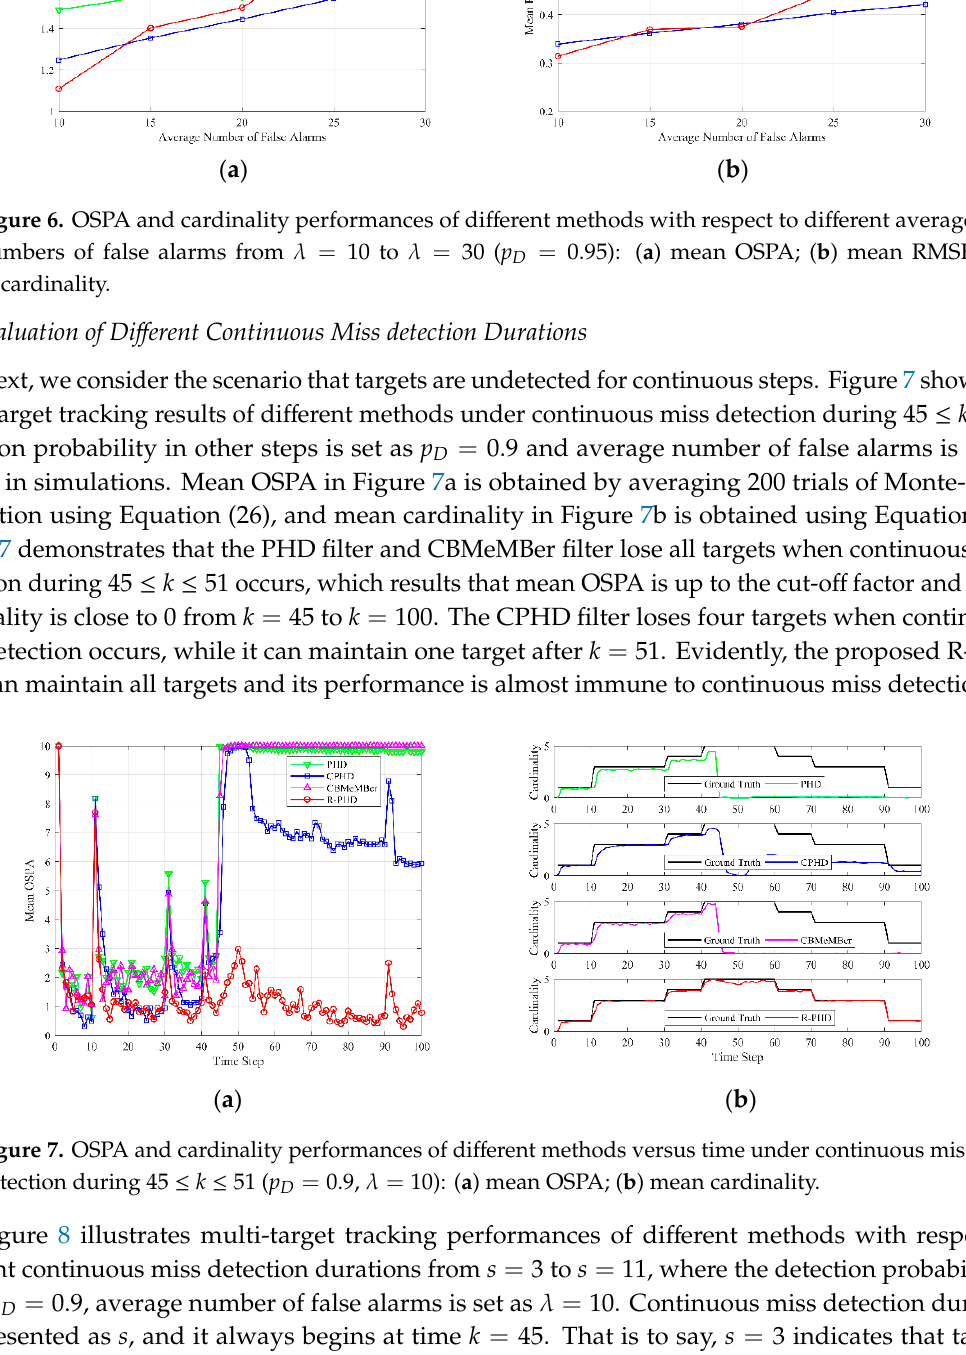
Figure 6. OSPA and cardinality performances of different methods with respect to different average numbers of false alarms from 10 =λ to 30 =λ ( 0.95 = cardinality.